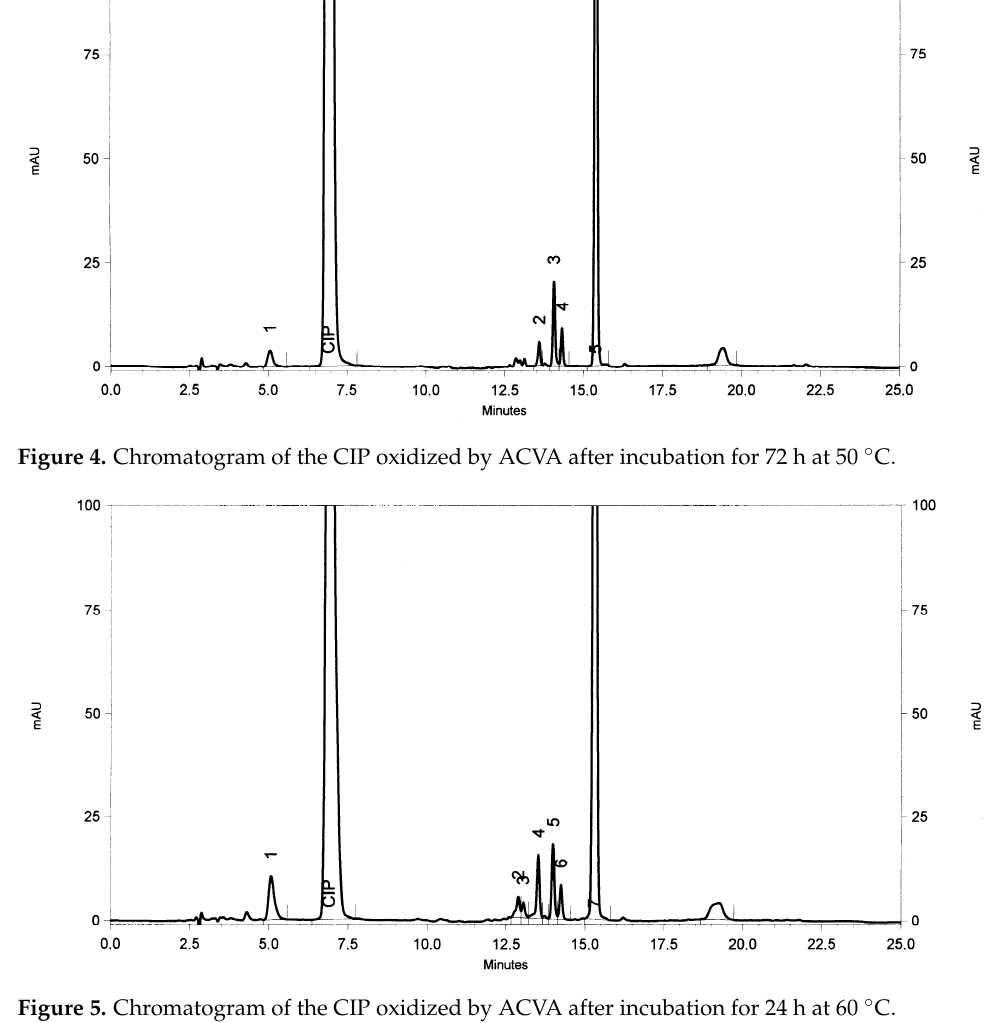
Figure 5. Chromatogram of the CIP oxidized by ACVA after incubation for 24 h at 60 °C.